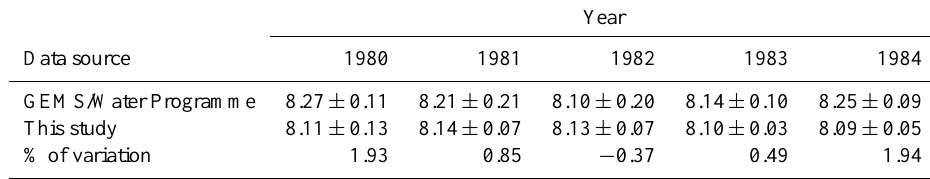
Table 1. pH at Luokou station during the period 1980–1984: a comparison of different data sources (arithmetic mean ± standard